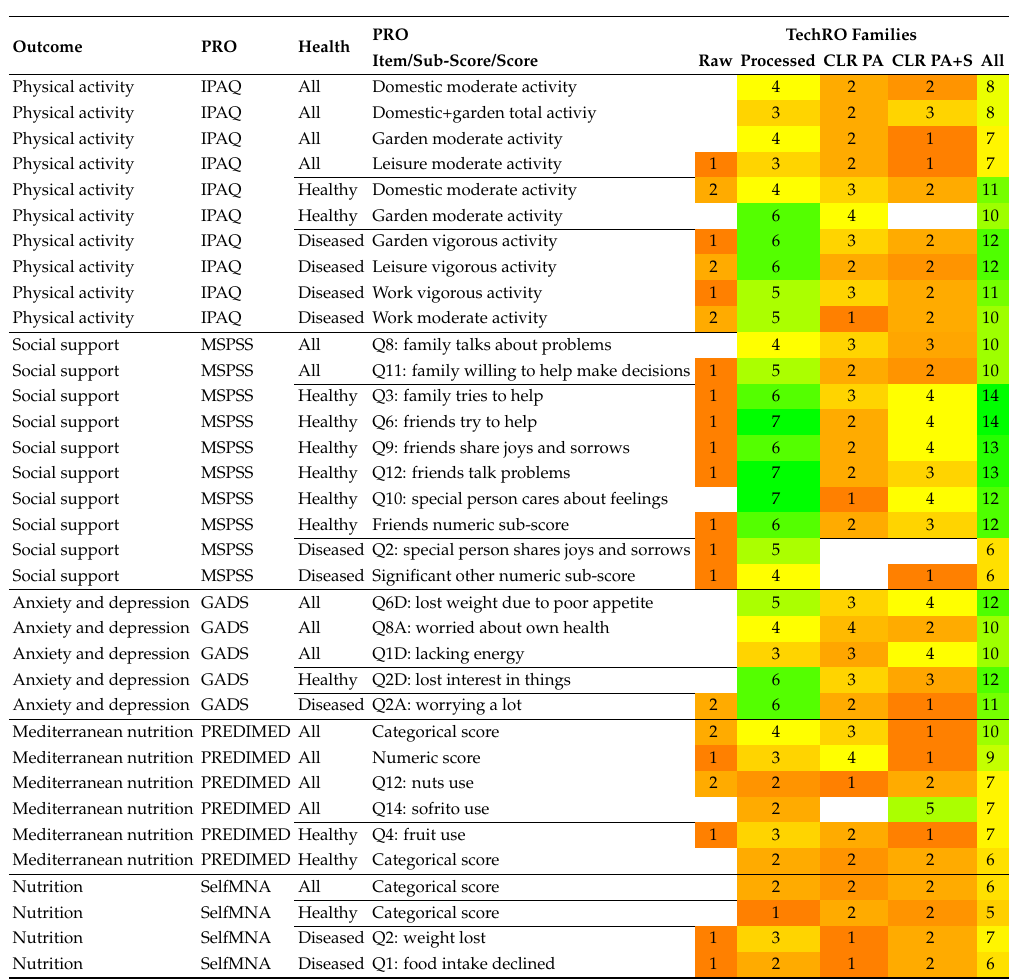
Table 6. PROs with high total count of significant Spearman correlations ( r S